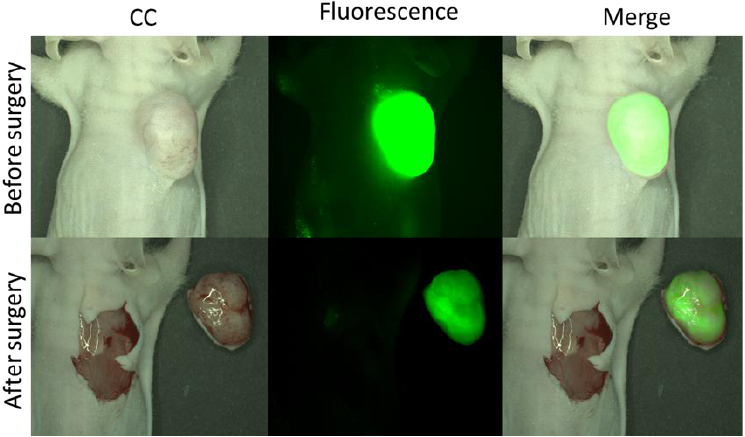
Figure 7. Representative images of Fluorescence Guided Surgery on PC3-PIP tumour bearing mice administered with 5 nmol of IRDye700DX-PSMA 24 h before (excitation/emission filters: (Ex: 615/665 nm, Em: 695/770 nm).